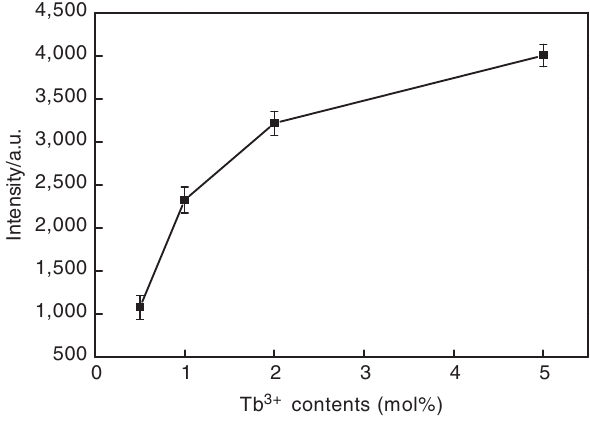
Figure 4: The relationship of Tb 3 þ contents and thermal lumines- cence spectrum of 70ZnO – 10P 2 O 5 – 20SiO 2 – x Tb 3 þ .